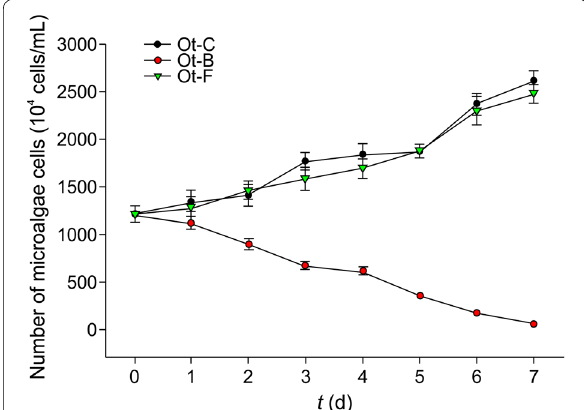
Fig. 2 Effects of CZBC1 on Oscillatoria tenuis growth. Ot‑C: O. tenuis control group; Ot‑B: O. tenuis bacterial suspension group; Ot‑F: O. + tenuis sterile filtrate +